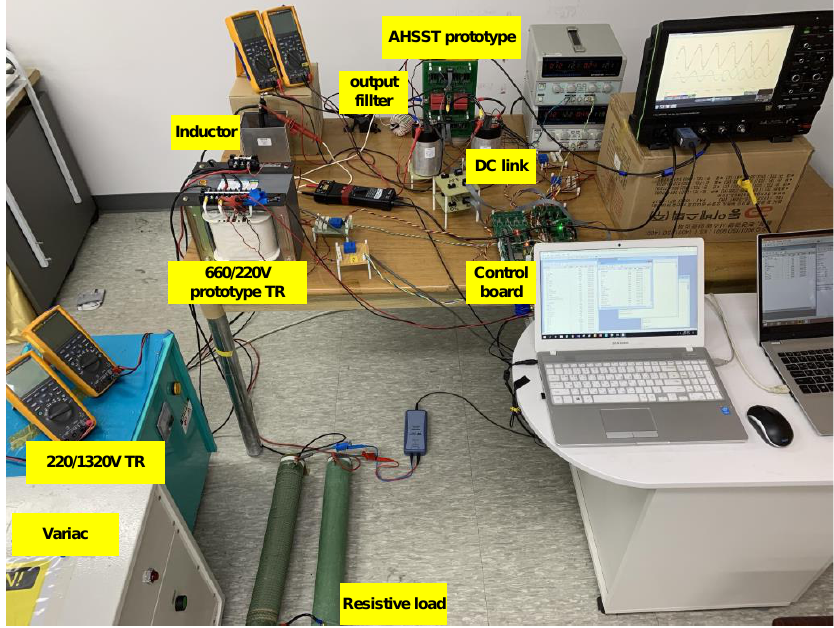
Figure 12. Experimental setup.